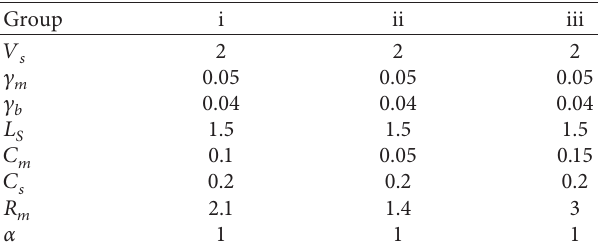
Figure 2: System dynamics model of suppliers and manufacturers behavior. Table 4: The external variable values in